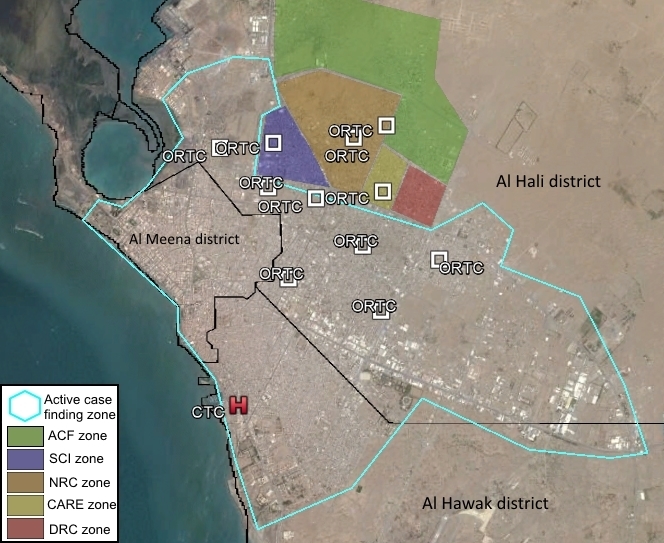
ACF: Action Contre la Faim; SCI: Save the Children International; NRC: Norwegian Refugee Council; DRC: Danish Refugee Council